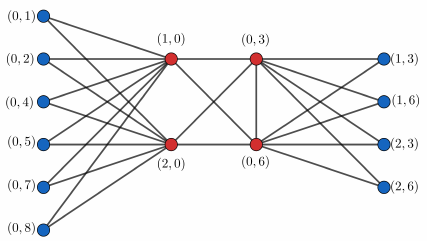
Figure 3. Diagram of the graph Γ ( Z 3 × Z 9 ).